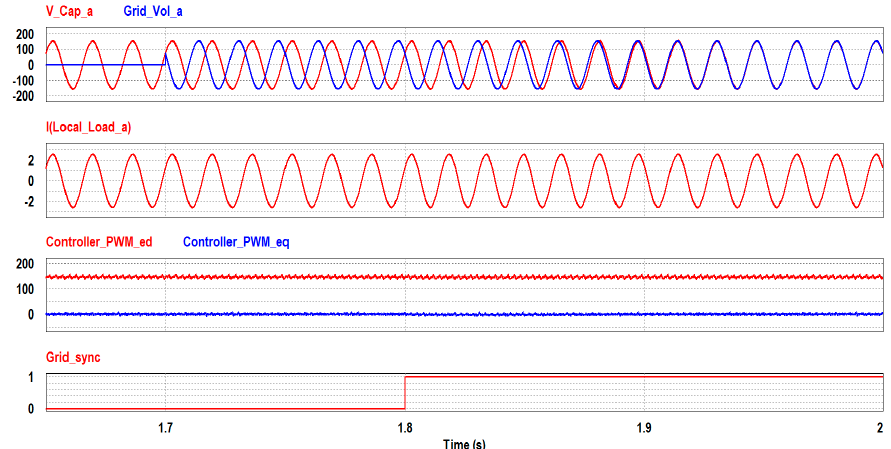
Figure 11. Simulation results in Case I. (SBGS ⟶ GS Mode) (From top to bottom: Measured a -phase inverter output voltage and grid voltage, a -phase local load current, PWM d - q controller outputs, and GS status signal).